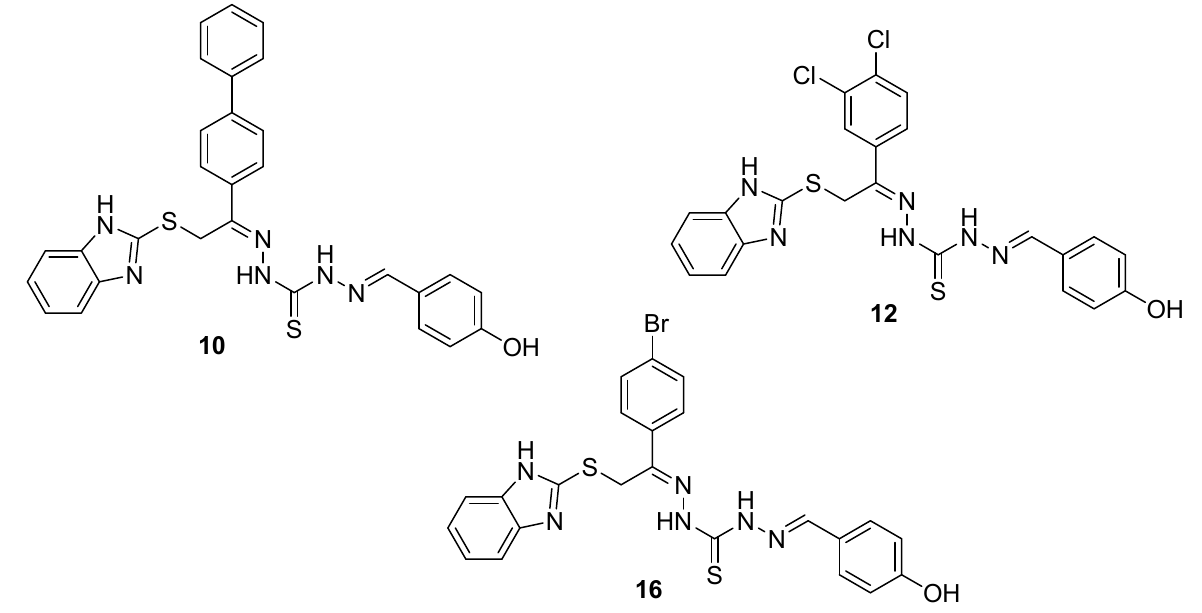
Figure 4. Structure-activity relationship of derivatives 10 , 12 and 16 .